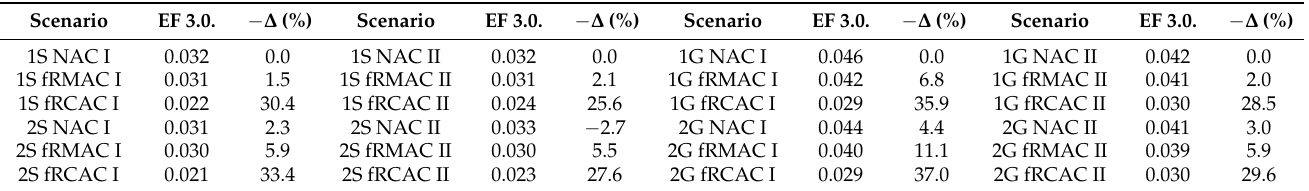
Table 8. Normalized and weighted results (EF 3.0) and differences − ∆ (%) of serviceability (SA).